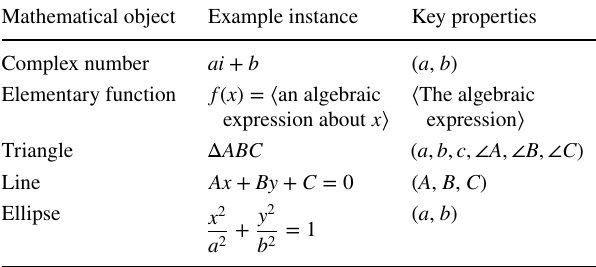
Table 2 Examples of key properties of different mathematical